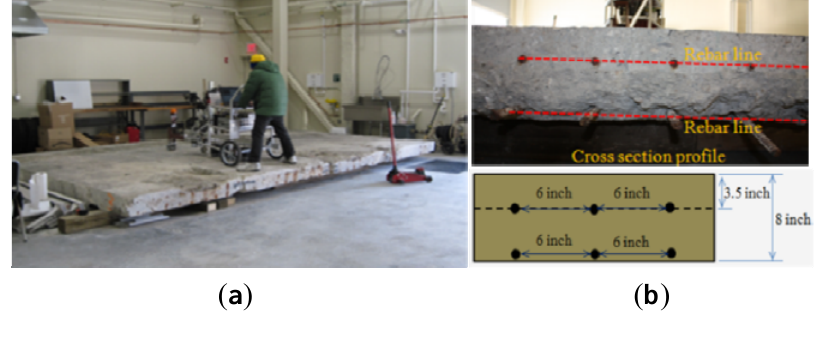
Figure 11. Concrete slab test configuration. ( a ) Test set-up. ( b ) Slab cross-section